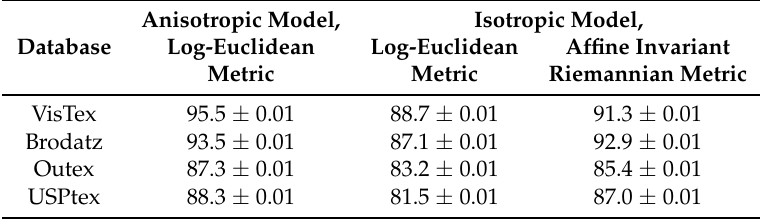
Table 7. Comparison between anisotropic and isotropic models, classification results based on FV: ¯ M